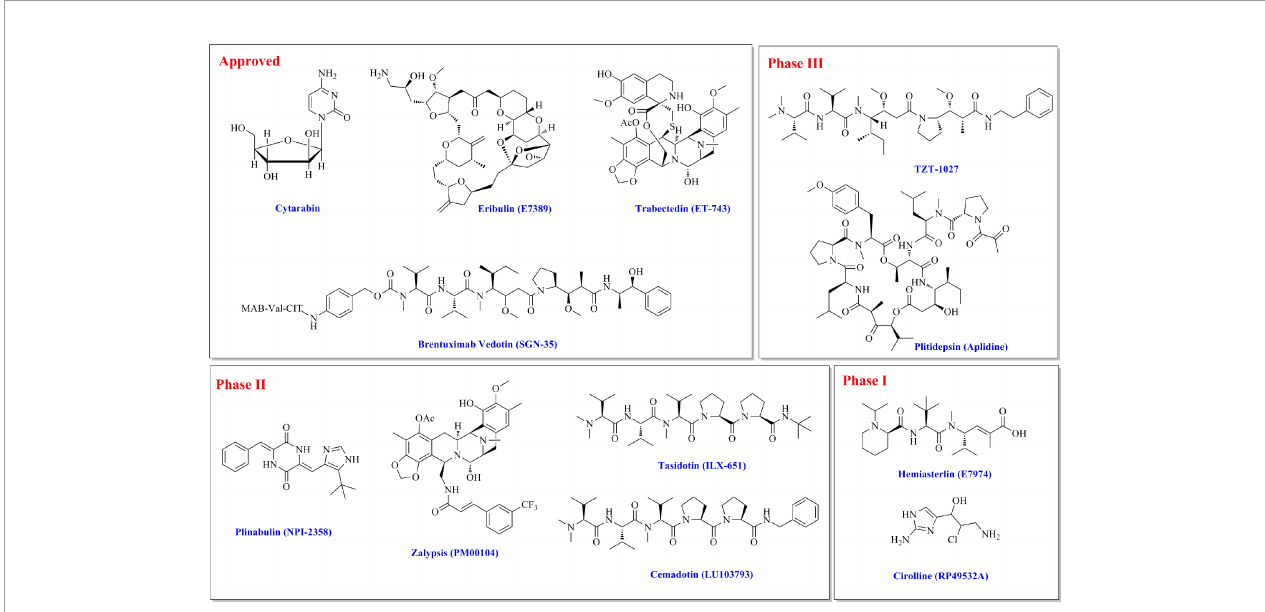
FIGURE 1 | Marine natural products originated antitumor drugs (approved and in phase III, II, and I clinical